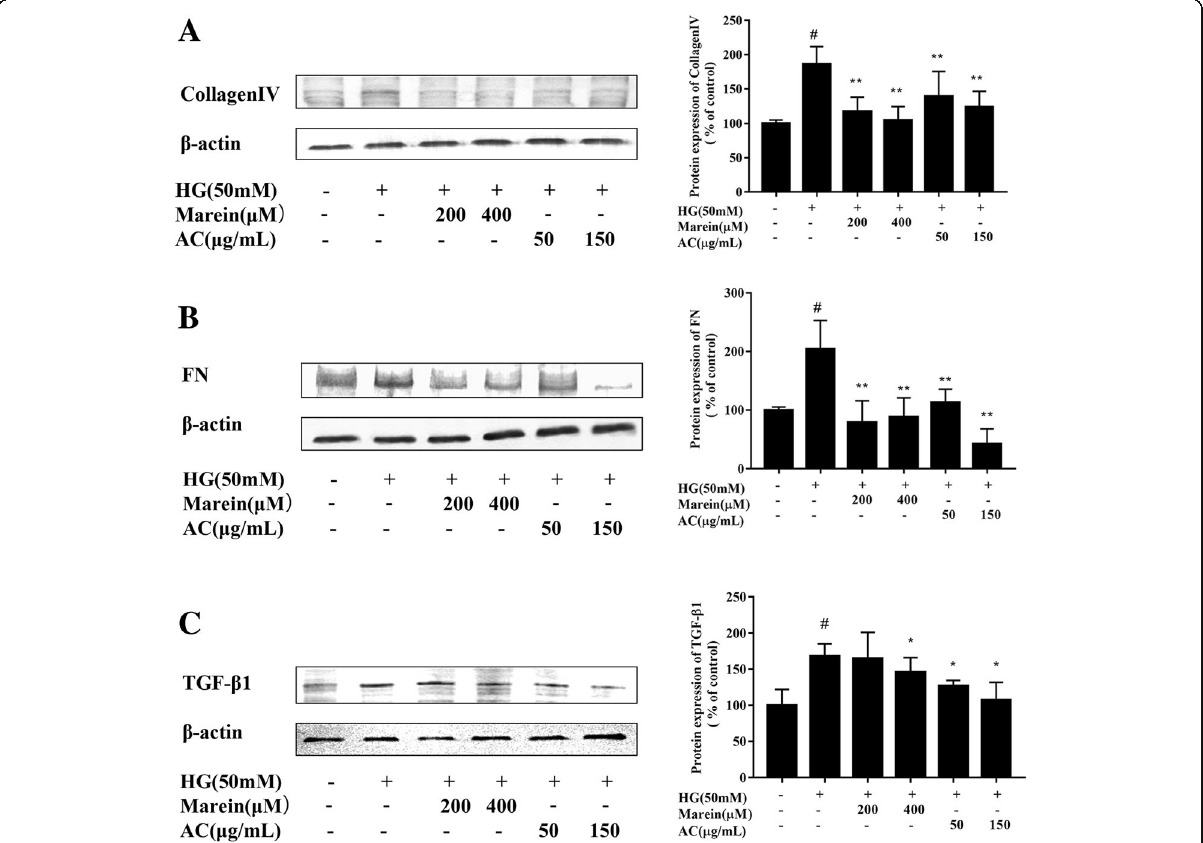
Fig. 2 a Inhibitory effect of AC and marein on collagen IV expression in HG-treated HBZY-1 cells by western blots. b Inhibitory effect of AC and marein on FN expression in HG-treated HBZY-1 cells by western blots. c Inhibitory effect of AC and marein on TGF- β 1 expression in HG-treated HBZY-1 cells by western blots. Note: Values were expressed as the mean ± SD, n = 4. # P < 0.01 versus normal group; * P < 0.05 versus control group; ** P < 0.01 versus control